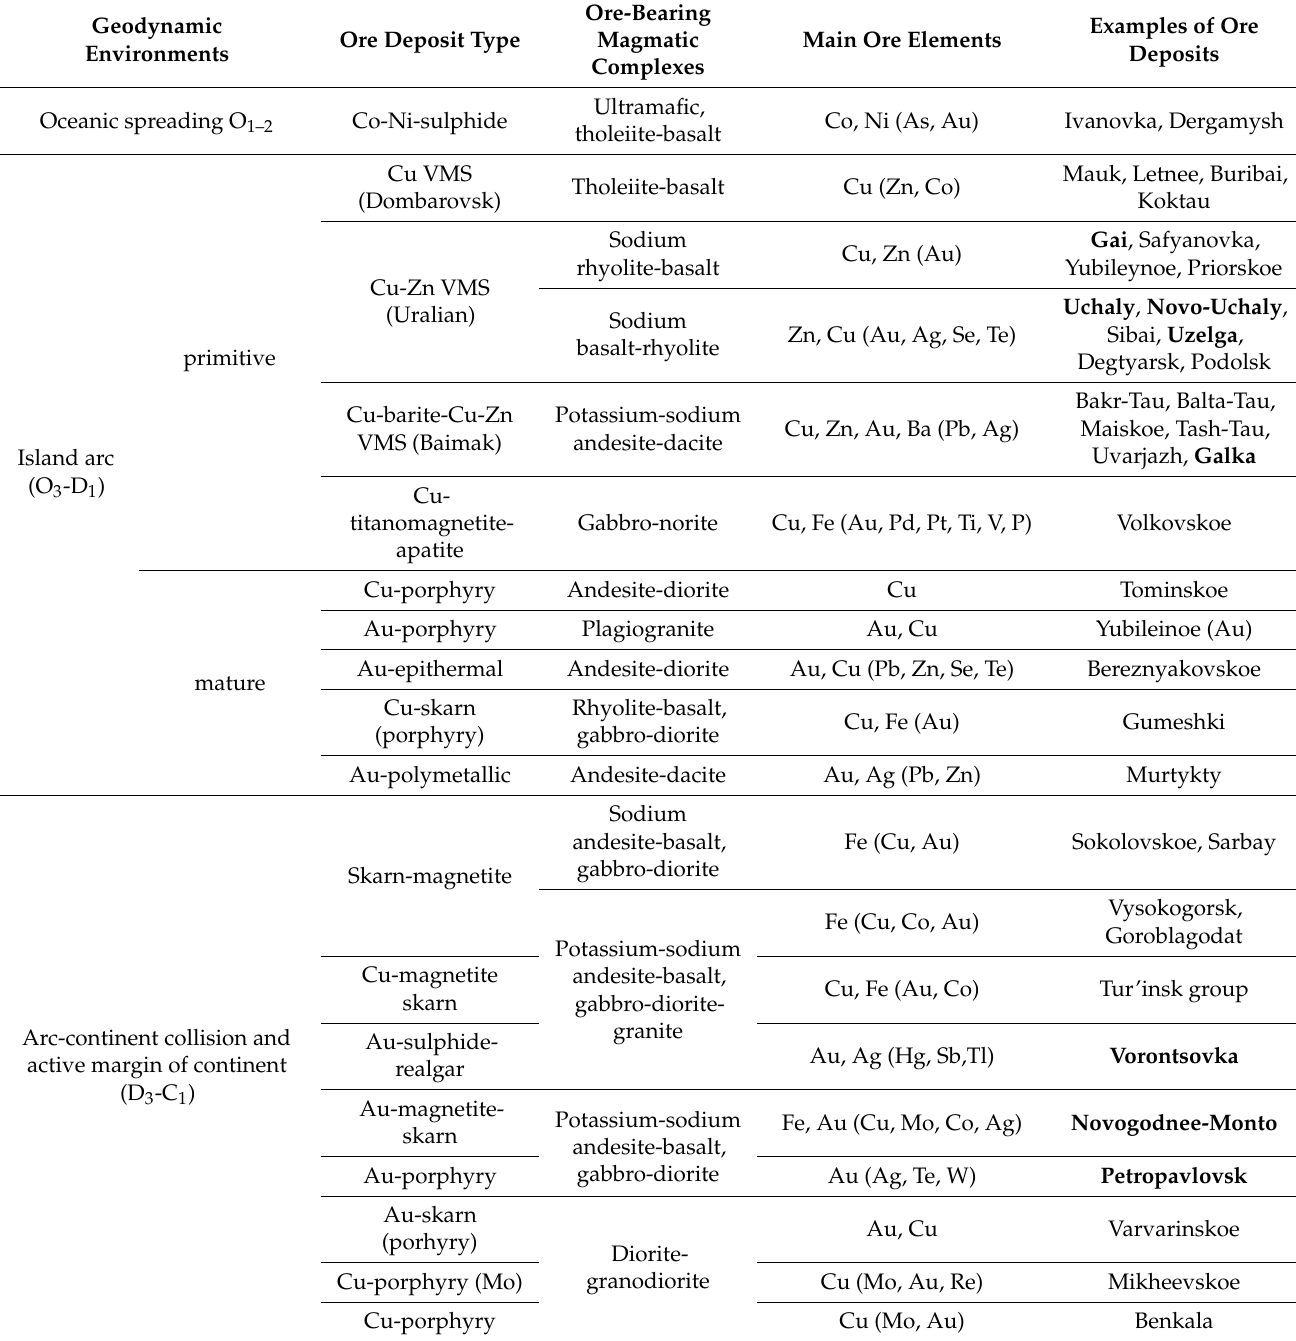
Table 1. Main endogenous Au- and Cu-bearing deposits of the